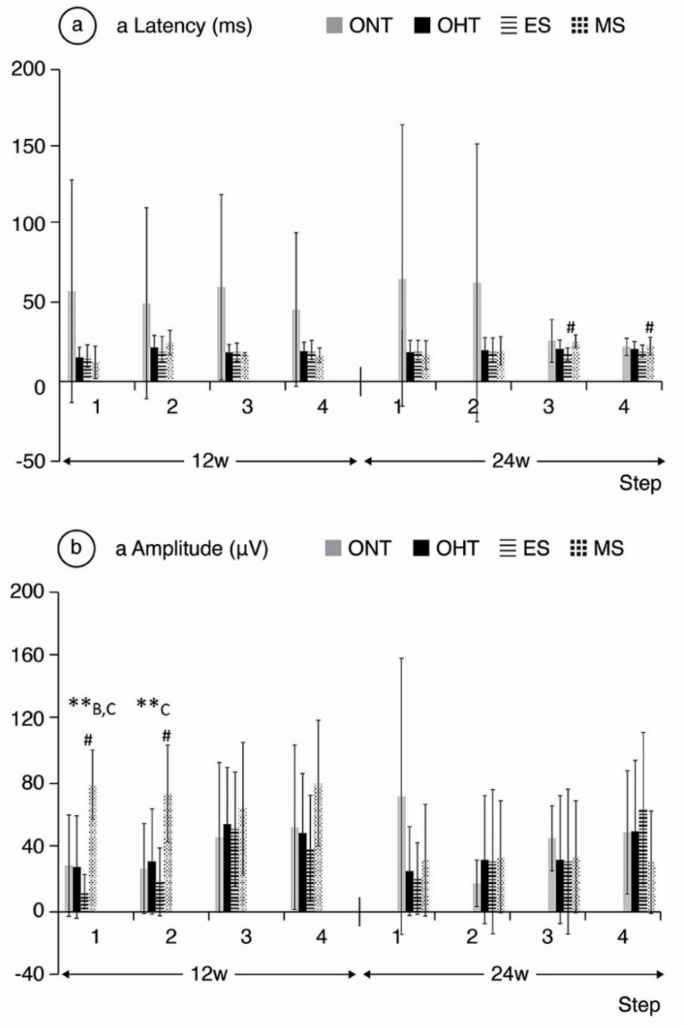
Figure 4. a-wave electroretinographic response in both the ocular normotension and ocular hyperten- sion cohorts and the ocular hypertension sub-groups at weeks 12 and 24. ( a ) a-latency in milliseconds of photoreceptors under scotopic conditions. ( b ) a-amplitude in microvolts of photoreceptors under scotopic conditions. Abbreviations: ONT: ocular normotension group; OHT: ocular hypertension group; ES: episcleral sclerosis group; MS: microspheres group; w: week; ms: milliseconds; µ V: microvolts; **: statistical differences between groups (ONT vs. ES vs. MS) (Kruskal–Wallis); #: statistical differences between the ES and MS groups; A: statistical differences between ONT and ES; B: statistical differences between ONT and MS; C: statistical differences between ES and MS. Scotopic test (rod response): step 1: − 40 dB, 0.0003 cds/m 2 , 0.2 Hz (20 recordings averaged); step 2: − 30 dB, 0.003 cds/m 2 , 0.125 Hz (18 recordings averaged); step 3: − 20 dB, 0.03 cds/m 2 , 8.929 Hz (14 recordings averaged); step 4: − 20 dB, 0.03 cds/m 2 , 0.111 Hz (15 recordings